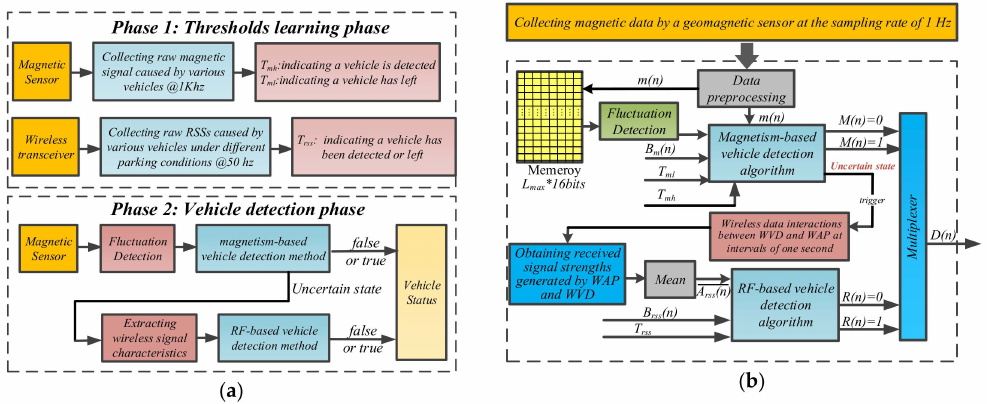
Figure 5. The implementation block diagram of proposed vehicle detection method. ( a ) Overview of our proposed vehicle detection method; ( b ) The implementation block diagram of our proposed fusion vehicle detection method.